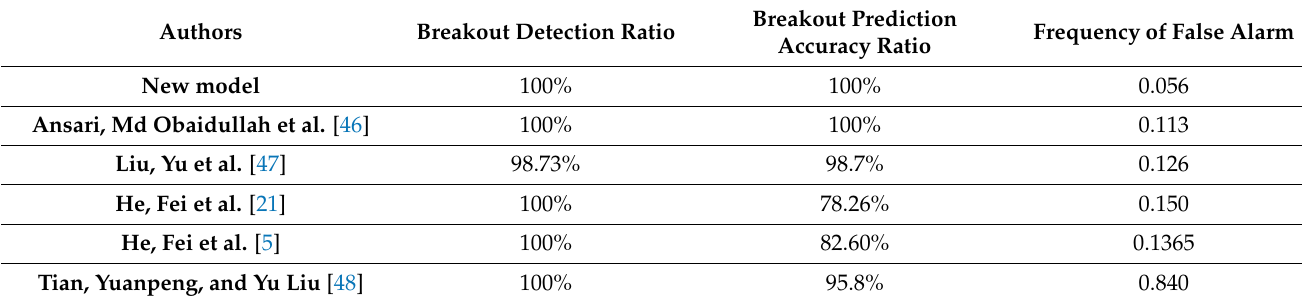
Table 10. Comparison of the new model’s results with the data of other